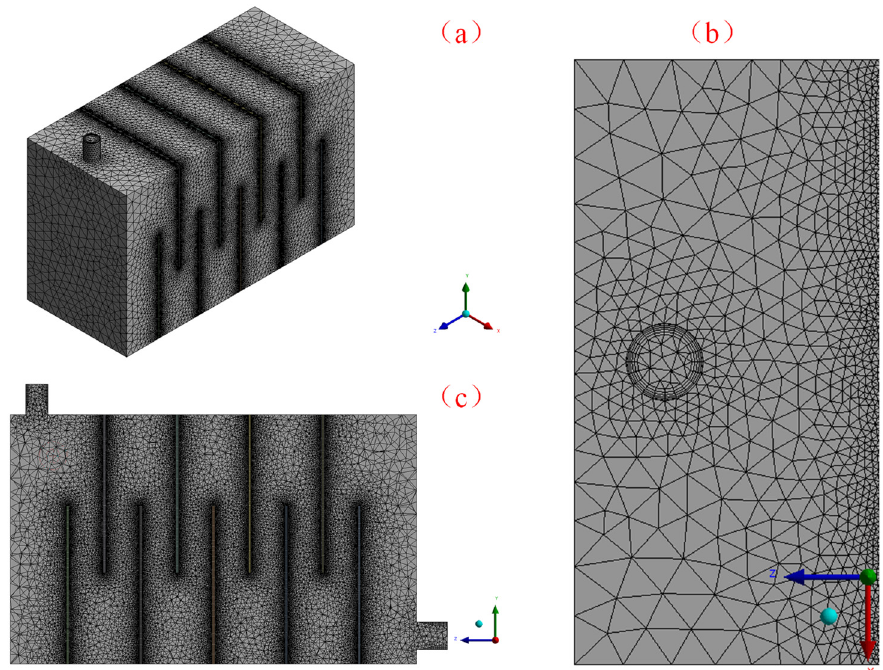
Figure 2. Diagram of grid division in computational domain (( a ): The 3D view of the grid; ( b ): The enlarged view of the grid at the inlet; ( c) : The YZ-plane cross-section of the grid at X = 315mm).